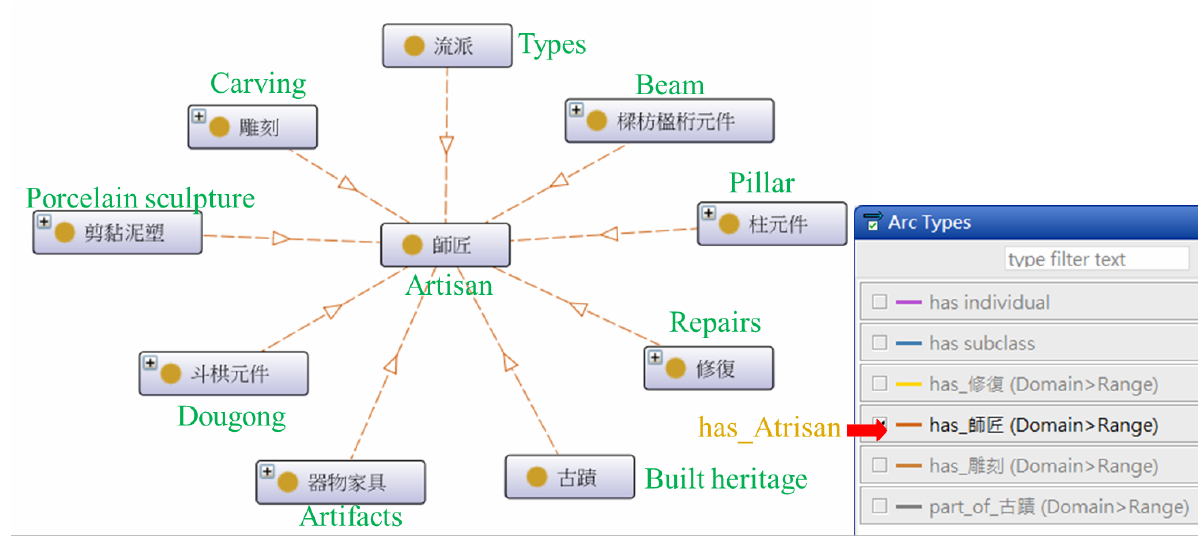
Figure 5. Object property of “has_artisan”.